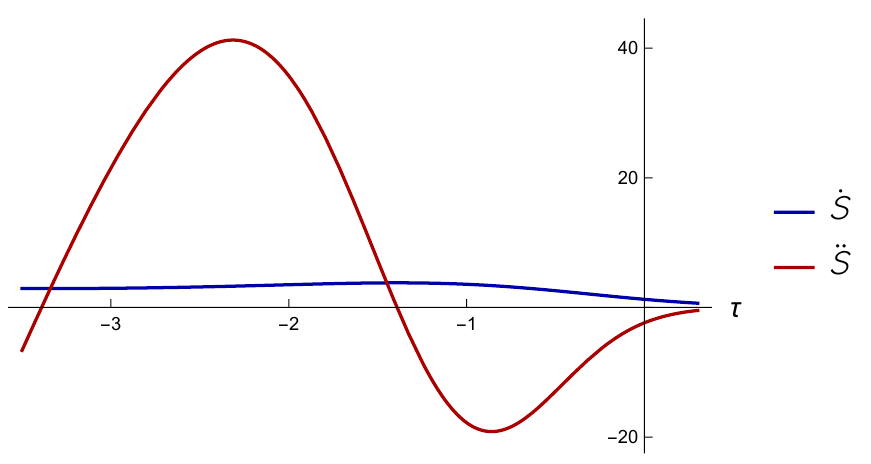
˙ ¨ S ( T ) , S ( T ) as a function of τ , for c B = − 1 , r = 0 . 67